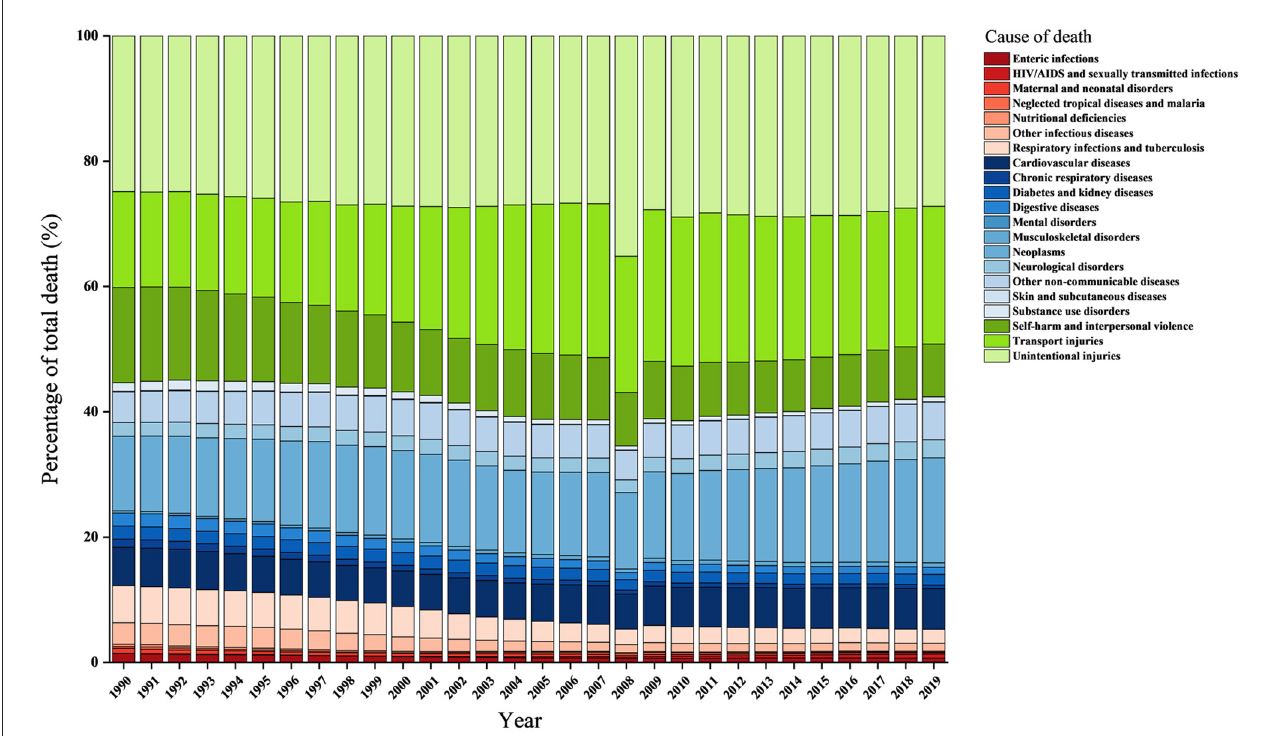
FIGURE2 Percentage of total deaths by level-2 causes in China, aged 10–19 years, both sexes from 1990 to 2019. All green bars are classified as injuries. All blue bars are classified as non-communicable diseases. All red bars are classified as communicable, maternal, neonatal, and nutritional